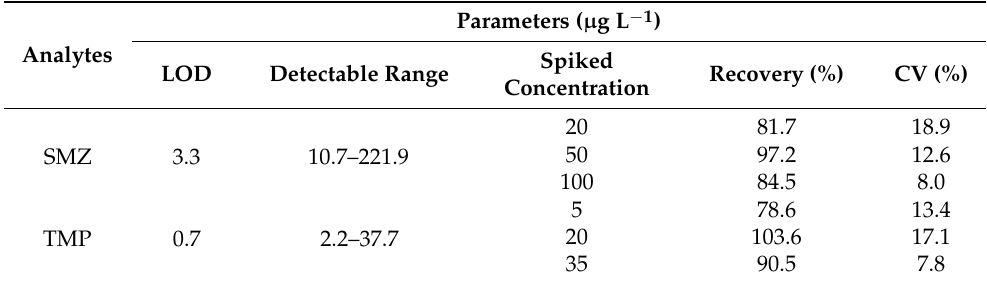
Table 2. Analytical characteristics of DWFPIA for the detection of SMZ and TMP, for the recoveries and CVs of spiked blank samples ( n = 3).